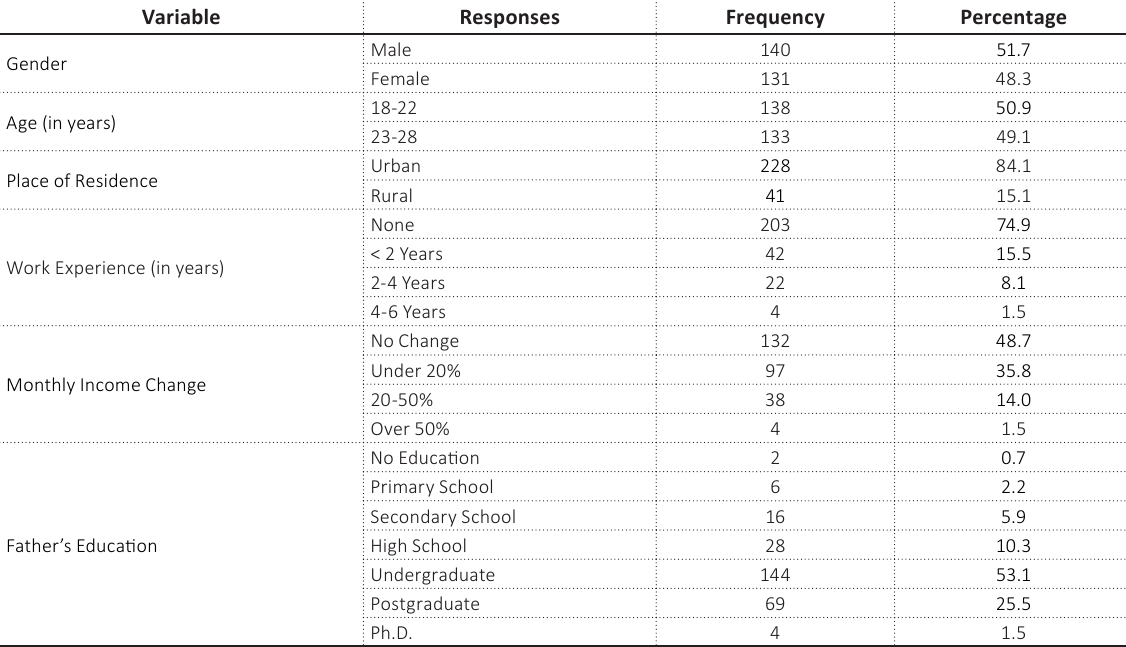
Table 1. Demographic and financial profile of 271